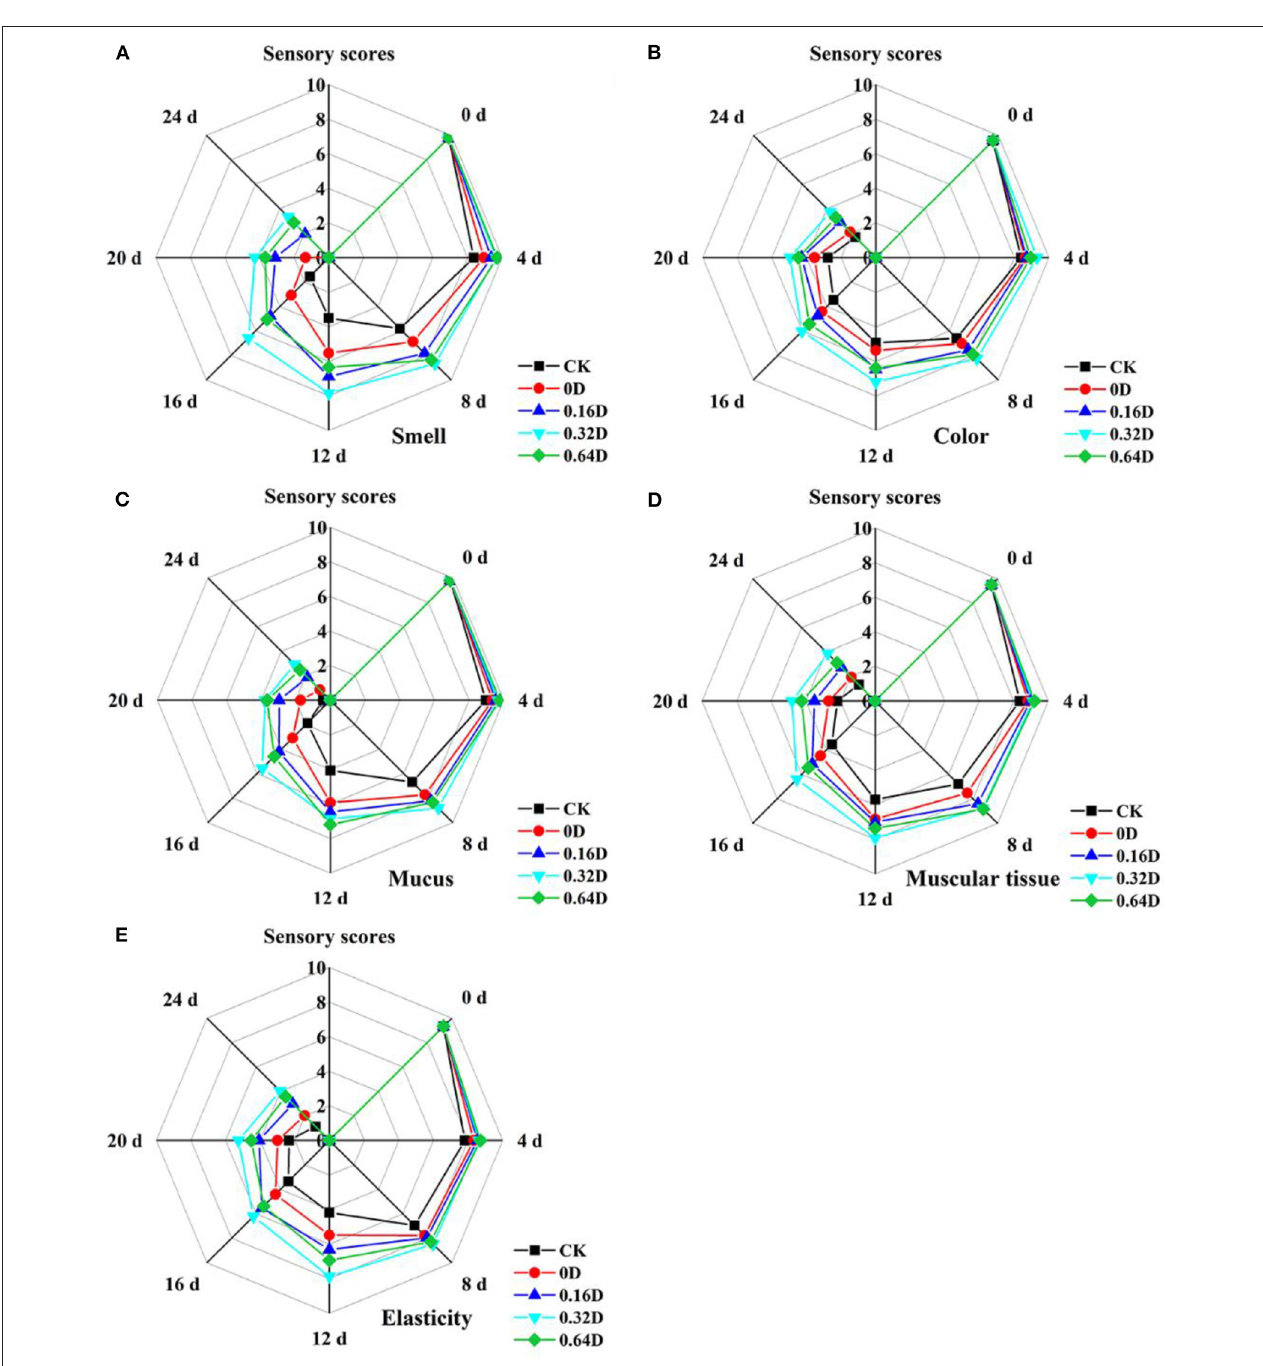
FIGURE 6 | Changes in (A) smell, (B) color, (C) mucus, (D) muscular tissue, and (E) elasticity of the turbot samples during the refrigerated storage [CK, washed with deionized water; 0D, immersed in weakly acidic electrolytic water (WAEW) for 10min, followed by coating with locust bean gum–sodium alginate (LBG-SA)-active coating; 0.16D, immersed in WAEW for 10min, followed by coating with LBG-SA coating with 0.16-g/L daphnetin; 0.32D, immersed in WAEW for 10min, followed by coating with LBG-SA coating with 0.32 g/L daphnetin; 0.64D, immersed in WAEW for 10min, followed by coating with LBG-SA coating with 0.64-g/L daphnetin].